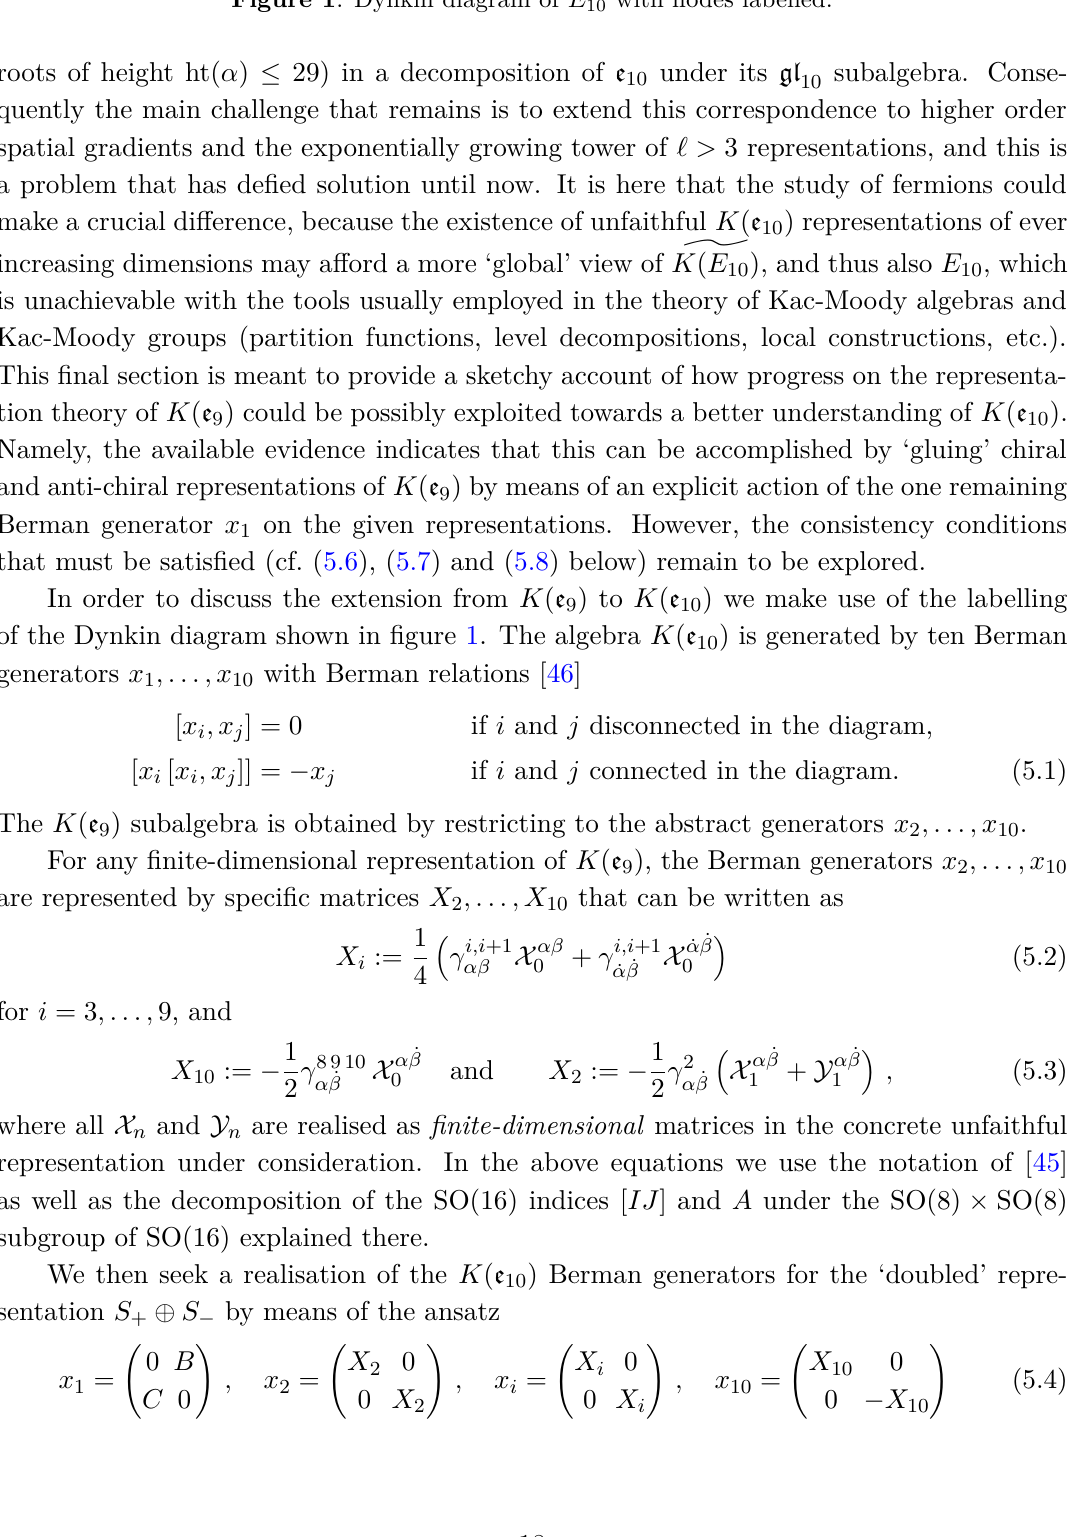
Figure 1 . Dynkin diagram of E 10 with nodes